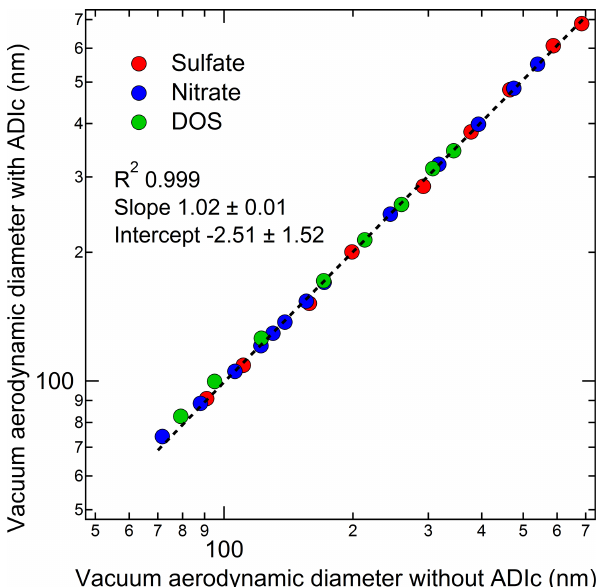
Figure 3. Particle size measured with an SP-AMS for 70–700nm particles (vacuum aerodynamic diameter) of sulfate, nitrate and or- ganics (from DOS) with and without concentration by the ADIc. Corresponding mobility diameters were